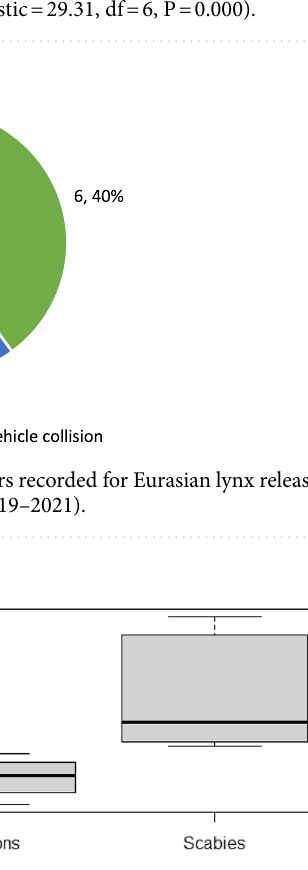
Table 2. Results of the Cox proportional hazard regression analysis (N = 50; the value of estimate means the covariate increases the hazard of death/decreases the survival time; HR 95 and HR 95 indicate the lower and upper 95% confidence limits, respectively). The significance of the proposed model was evidenced by the Likelihood ratio test (Statistic = 43.6, df = 6, P = 0.000), the Wald test (Statistic = 23.61, df = 6, P = 0.000), and the Score (logrank) test (Statistic = 29.31, df = 6, P = 0.000).